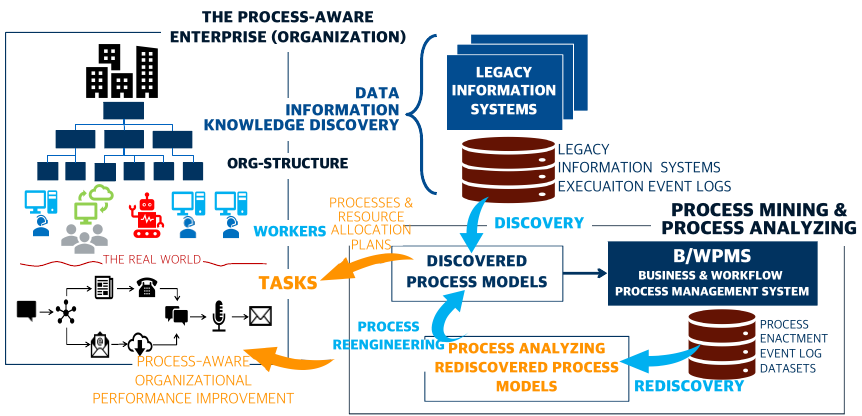
Figure 1. Mining and analyzing activities on a process-aware enterprise: the rationale of functional integration of process mining and process